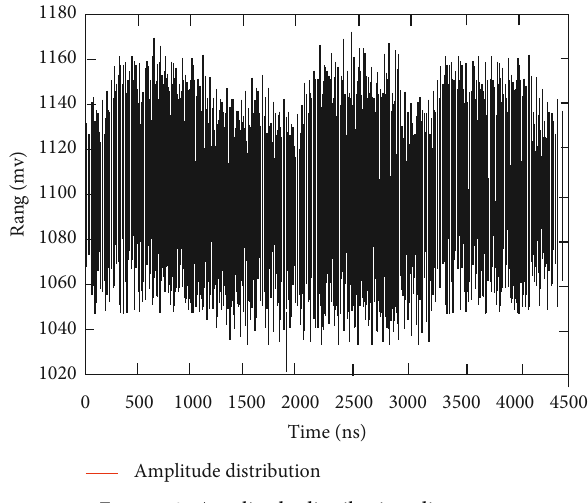
Figure 2: Amplitude distribution diagram.